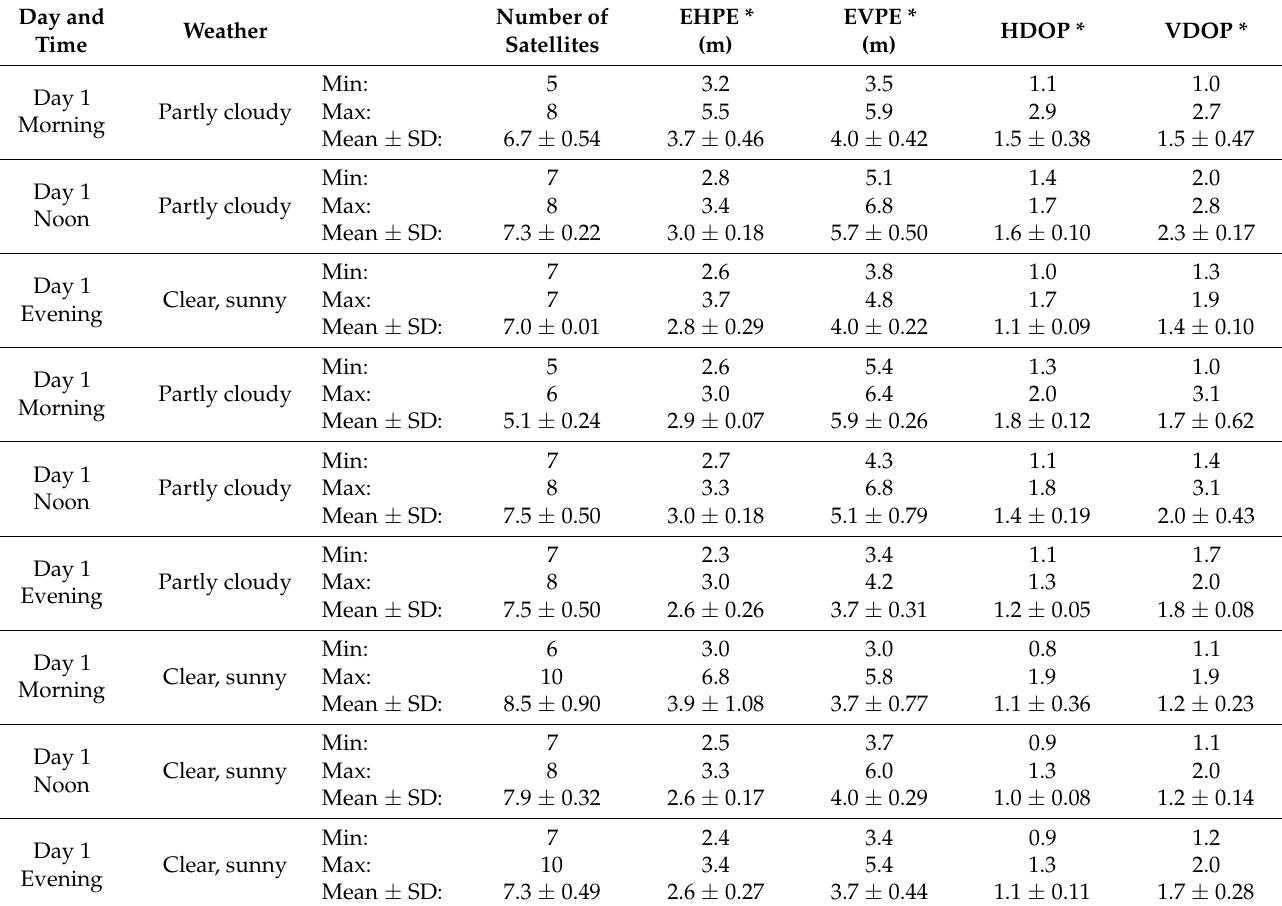
Table 3. Data related to the GPS signal quality at the test time.